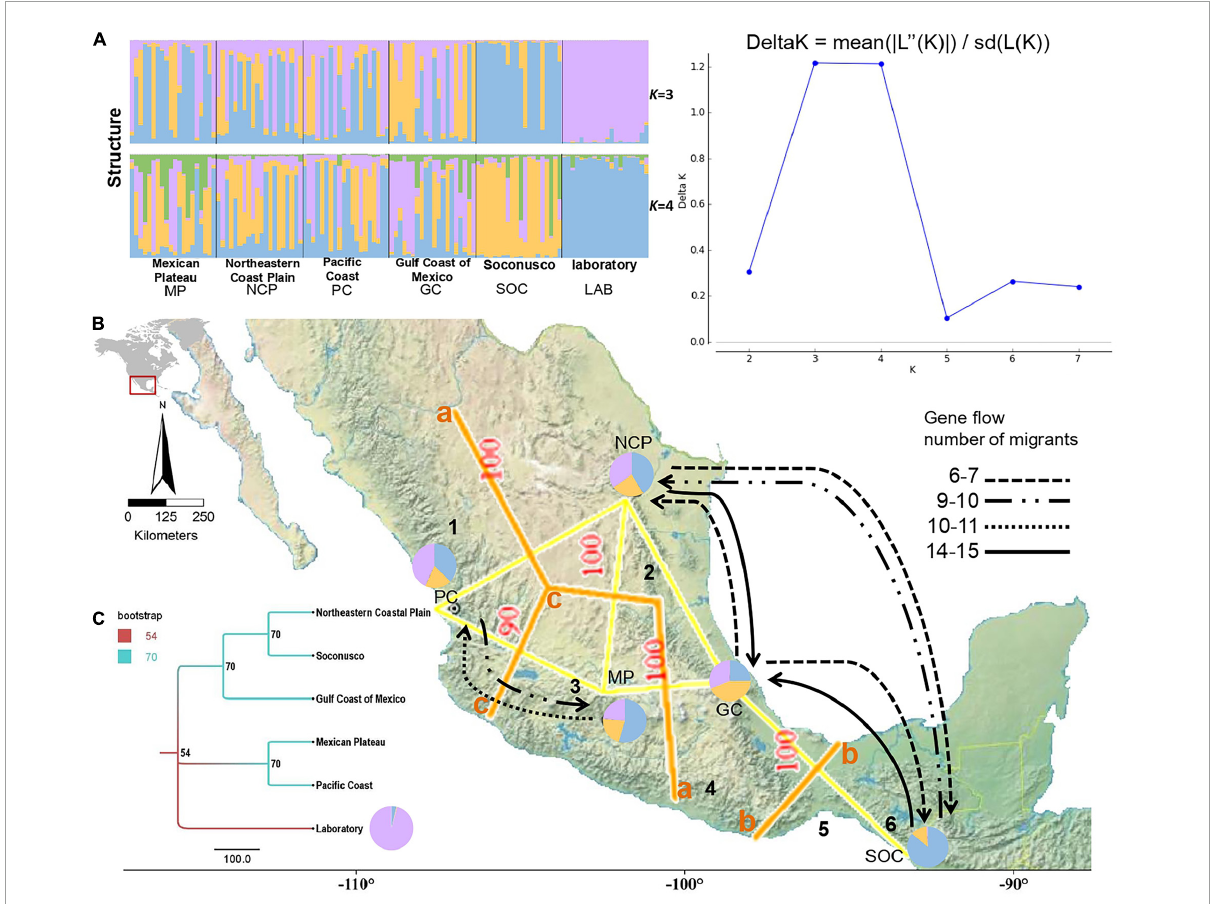
FIGURE1 (A) Genetic structure of mexfly based on the nDNA microsatellite loci estimated using STRUCTURE and visualized with Distruct. The bar plot and pie chart indicating the blue, yellow, and purple colors of graphics indicate three genetic groups with Admixture model: K = 3, 25 iterations of each K (1 − 8) and delta K . (B) Map of five collected localities in Mexico showing the three main genetic barriers with nDNA and the orange line (a, b, and c) found by the Monmonier algorithm; thickness and the number on the side of the barriers indicate the percentage of bootstrap support. The map shows the migration of mexfly populations, and the arrows represent the effective number of migrants in a generation. The main physiographic features and/or regions’ biogeographical boundaries for fruit fly are delimited with lines: (1) SMOcc: Sierra Madre Occidental, (2) SMO: Sierra Madre Oriental, (3) TMVB: Trans Mexican Volcanic Belt, (4) SMS: Sierra Madre del Sur, (5) IT: Isthmus of Tehuantepec, (6) SCh: Sierra Madre de Chiapas. (C) Genetic distance of mexfly populations obtained by Neighbor-Joining of